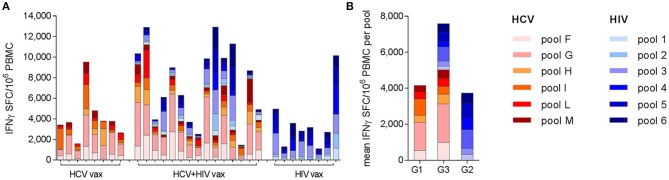
Breadth and specificity of antigen-specific T cell responses as determined by ex vivo IFN-γ ELISpot assays: each bar shows the contribution of individual peptide pools to the total response to the NSmut (red shades) and HIVconsv (blue shades) immunogens at the peak of the response after boosting vaccinations. Although the peak response was most frequently observed at day 63, the day 84 or 98 response is shown for the few individuals with a later peak, to illustrate the maximal breadth of individual responses. (A) Individual subjects are shown, indicated by trial identifier on x axis; (B) mean values per group.